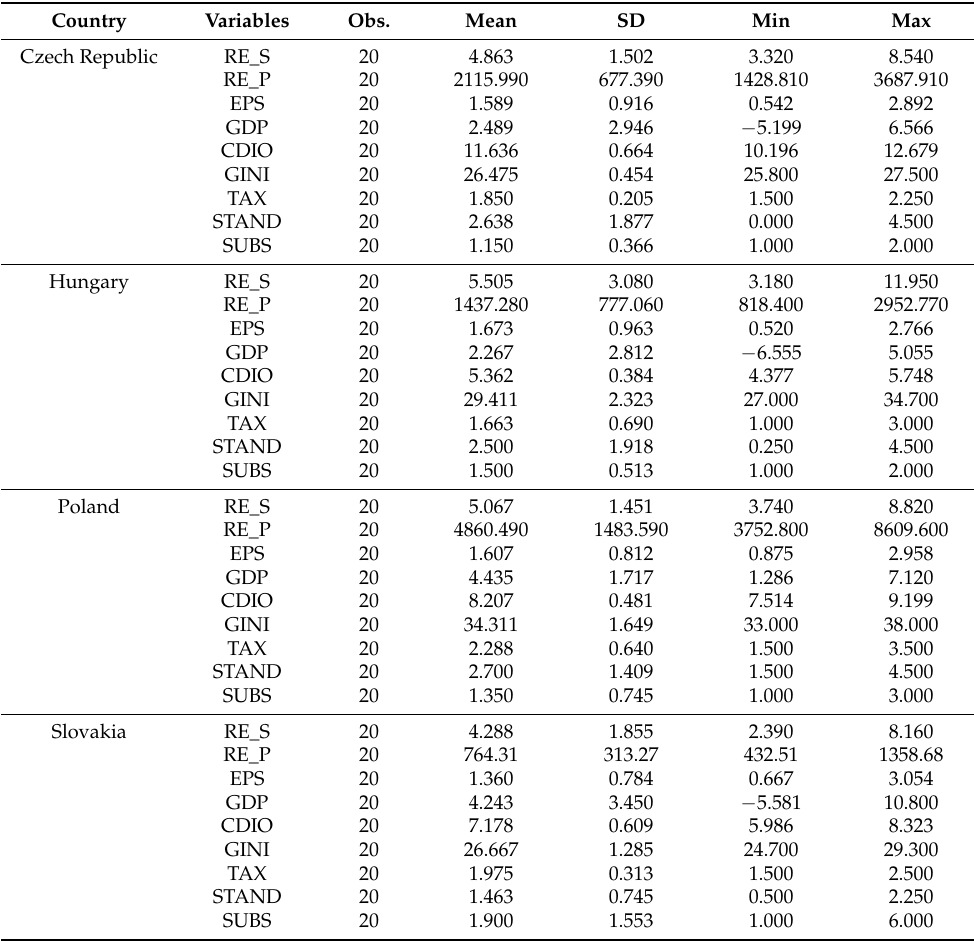
Figure 2. Share of renewable energy production in total energy production (in %). Table 2. Descriptive statistics for